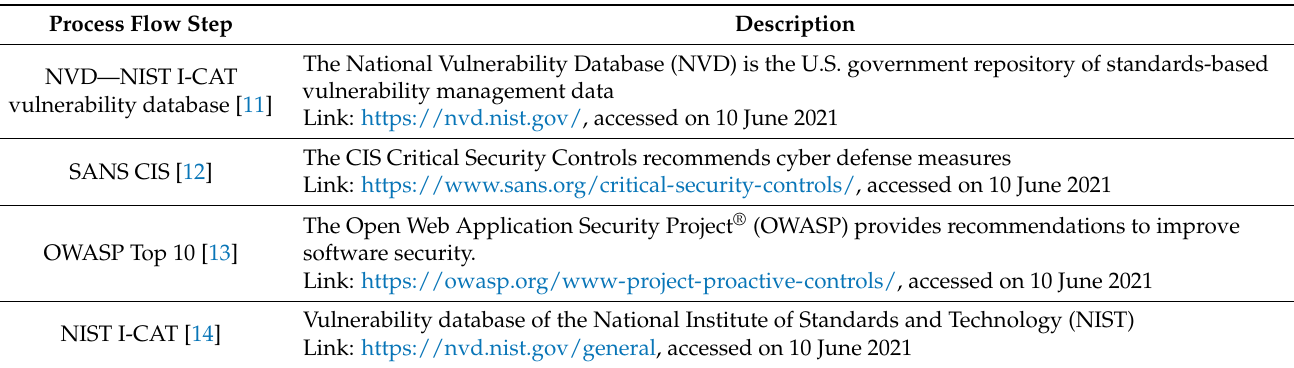
Table 4. Cybersecurity risks and vulnerabilities list.